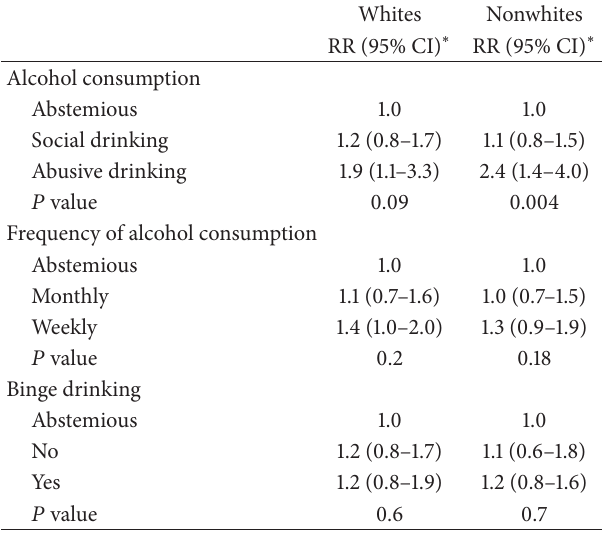
Table 3: Association between alcohol consumption and hyperten- sion according to skin